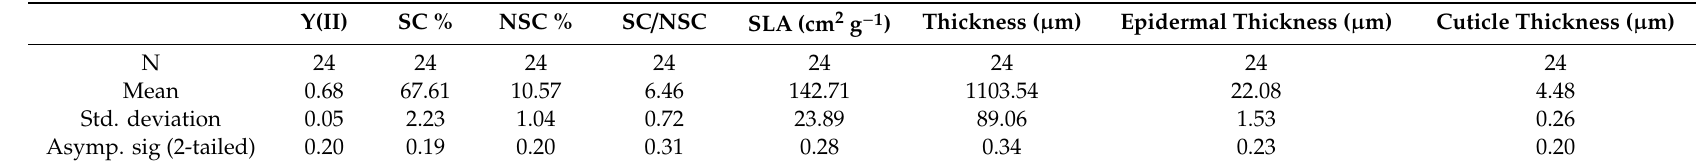
Figure A2. The relationships between leaf area, mass and wind speed for P. thunbergii along the coast-inland gradient. Table A1. One-Sample Kolmogorov-Smirnov